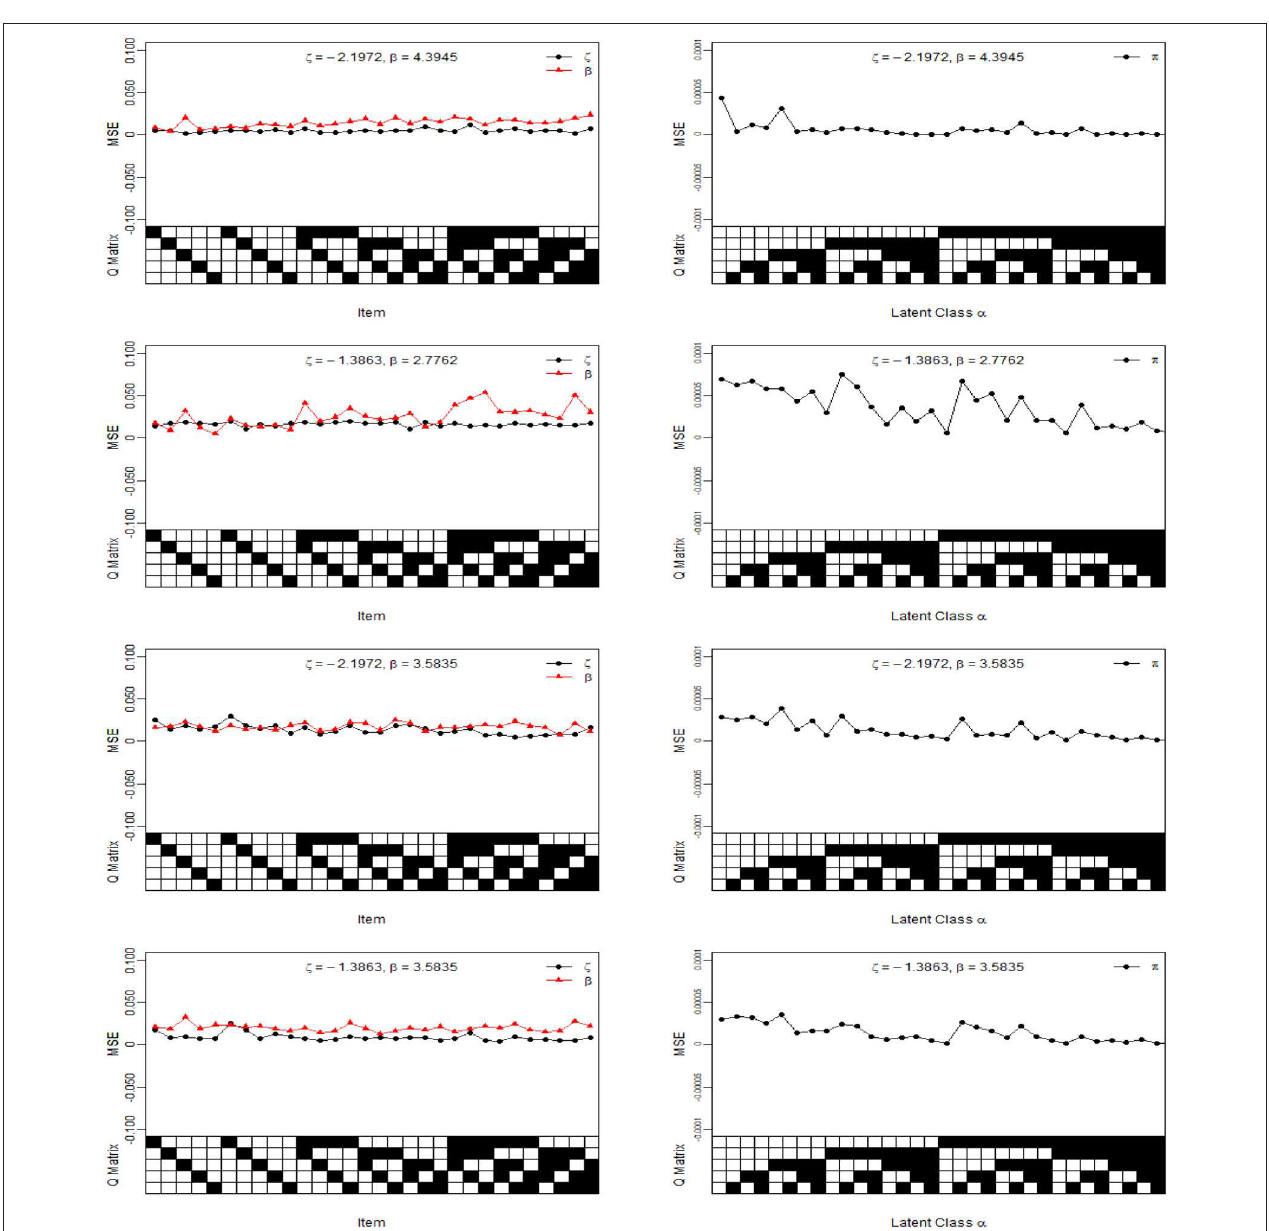
FIGURE 3 | The MSE of intercept, interaction and class membership probability parameters under four different diagnosticity cases. The Q Matrix denotes the skills required for each item along the x axis, where the black square = “1” and white square = “0.” The α ck denotes the examinee who belongs to the c th latent class whether has mastered k th skill, where the black square = “1” for the presence of a skill and white square = “0” for the absence of a skill, α c = ( α c 1 , ... , α cK ) ′ . Note the MSE values are estimated from 25 replications.